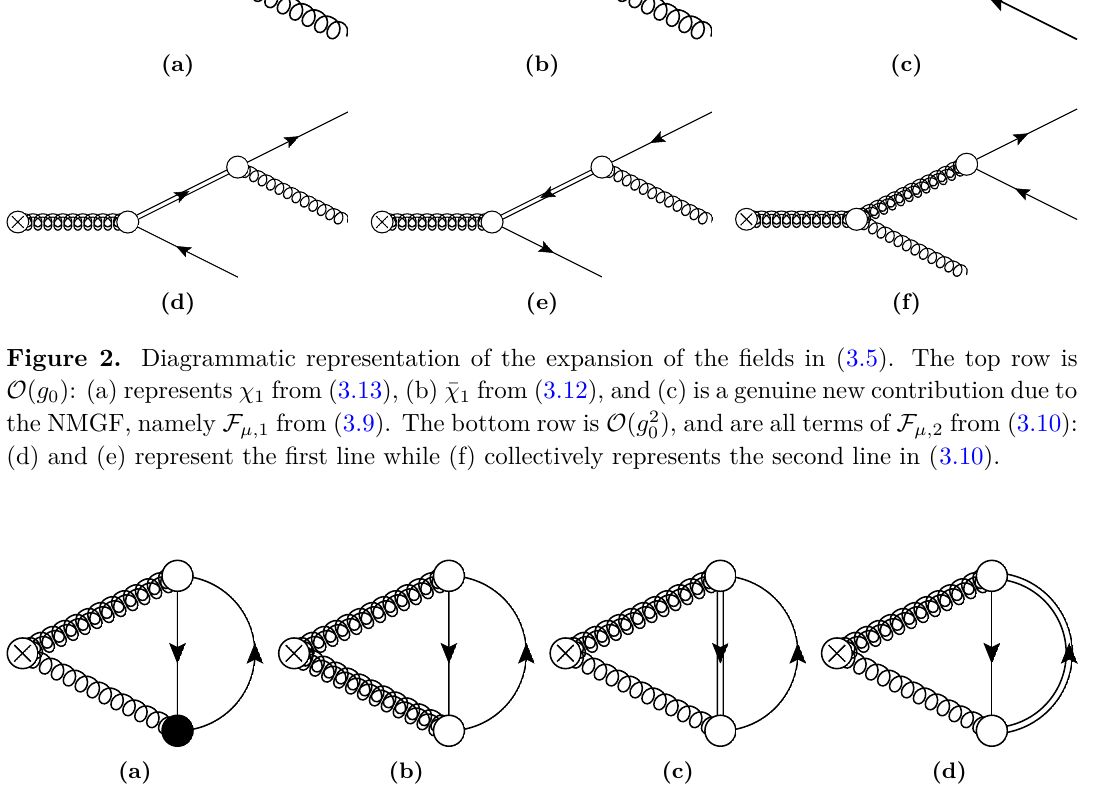
Figure 3. Diagrammatic representation of the contributions to h E i due to the NMGF, whose total value is given in (3.21). (a) represents E χ, 1 from (3.15), (b) represents E χ, 2 from (3.16), and the combination of (c) and (d) represents E χ, 3 from